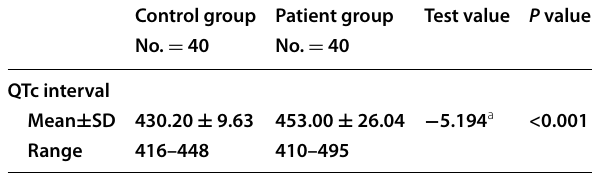
SD standard deviation, HS highly significant